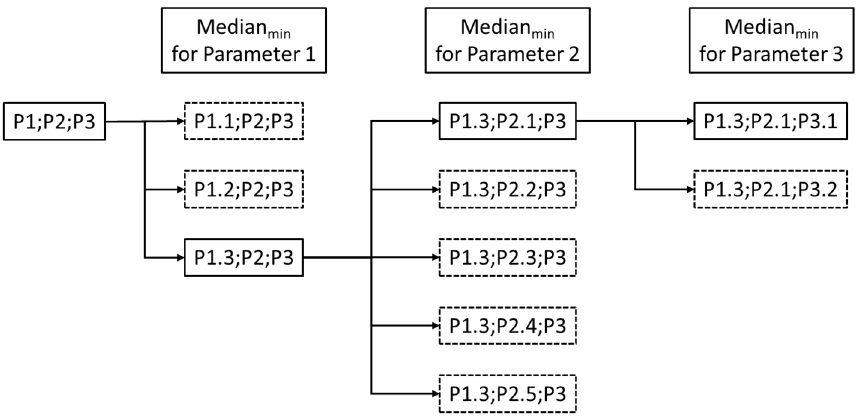
Figure 5. Construction of the decision trees for the classification of the roughness data. The order of the refinement parameters is permuted to obtain all possible outcomes independently from each other.